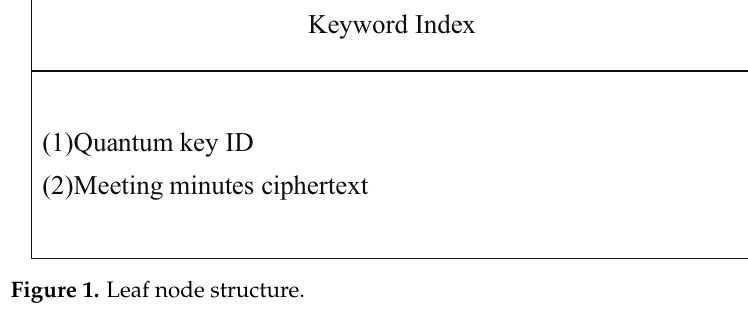
Figure 1. Leaf node structure.